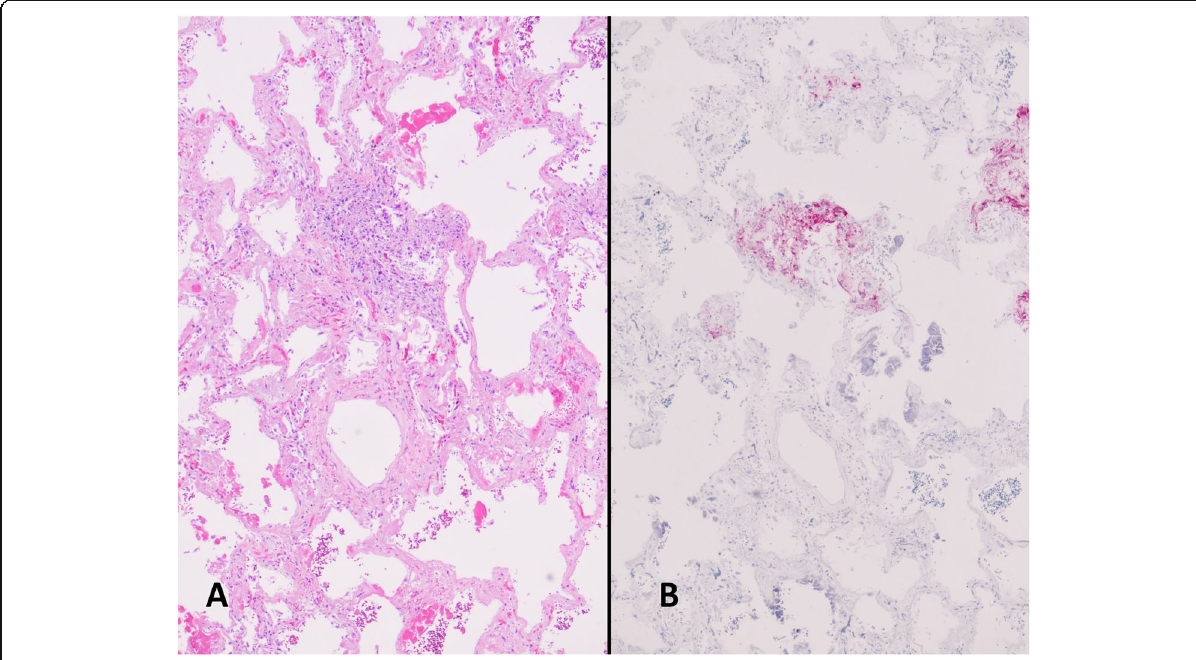
Fig. 6 Besides DAD, examination of the lungs confirm the presence of LAM cells ( a ). Immunohistochemical stain for HMB-45 ( b ) confirms the origin of these atypical cells are LAM cells ( a hematoxylin and eosin, original magnification 40X; b HMB-45, original magnification 40X)